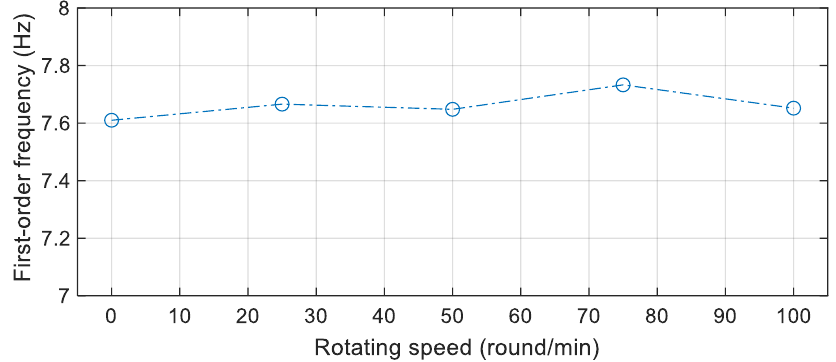
Figure 7. Modal frequency identified by RDT-SSI method.